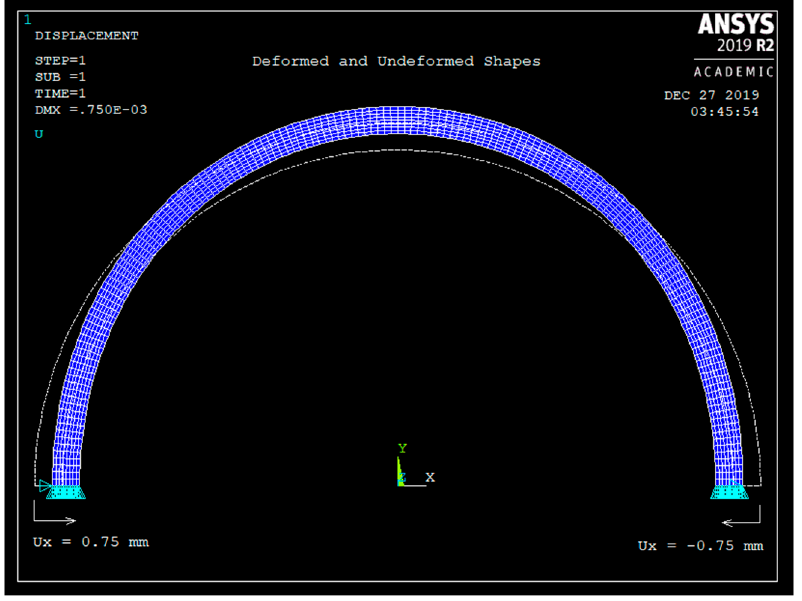
Figure 7. The deformed and the undeformed shapes with boundary conditions.